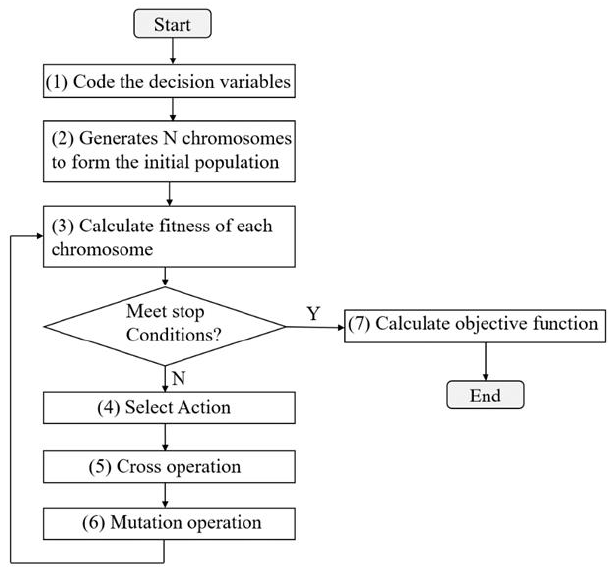
Figure 4. Genetic algorithm flow chart.